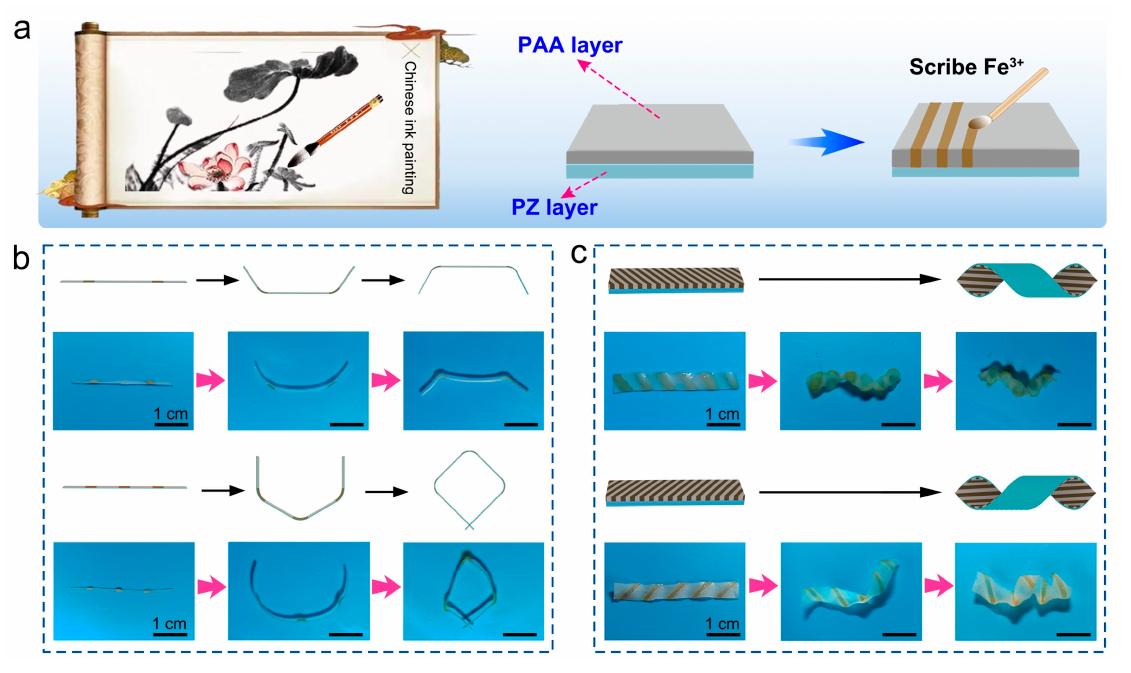
Figure 6. Fabrication of PZ-PAA@Fe 3+ heterogeneous hydrogel actuators through painting Fe 3+ solutions onto PZ-PAA surface (PAA side) and their 2D and 3D deformation in response to pH = 13. ( a ) Schematic illustration of the locally Fe 3+ Coordinated PZ-PAA@Fe 3+ heterogeneous hydrogel. Controllable actuation of ( b ) dot- and ( c ) stripe-patterned hydrogels.